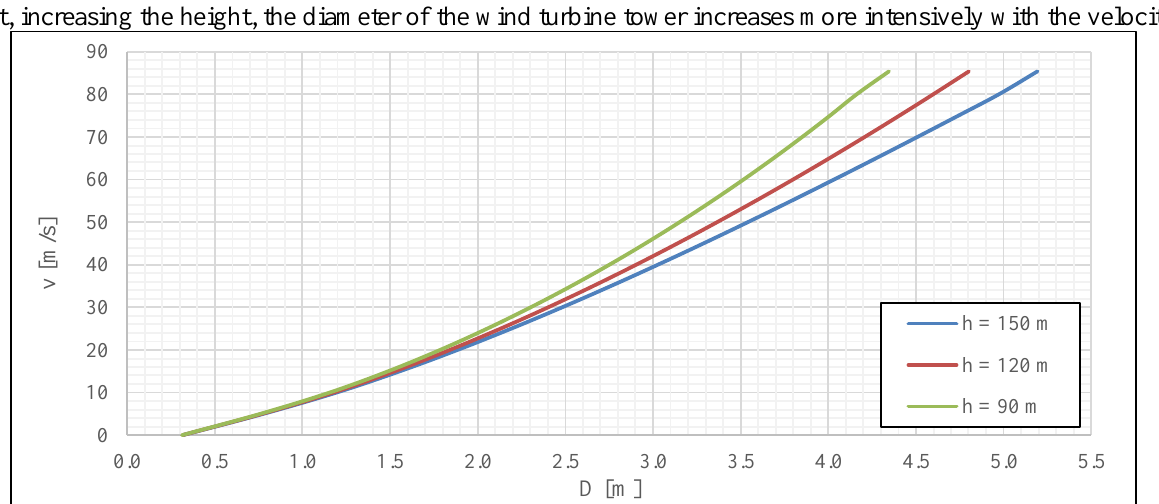
Figure 3. Tower diameter as a function of wind velocity